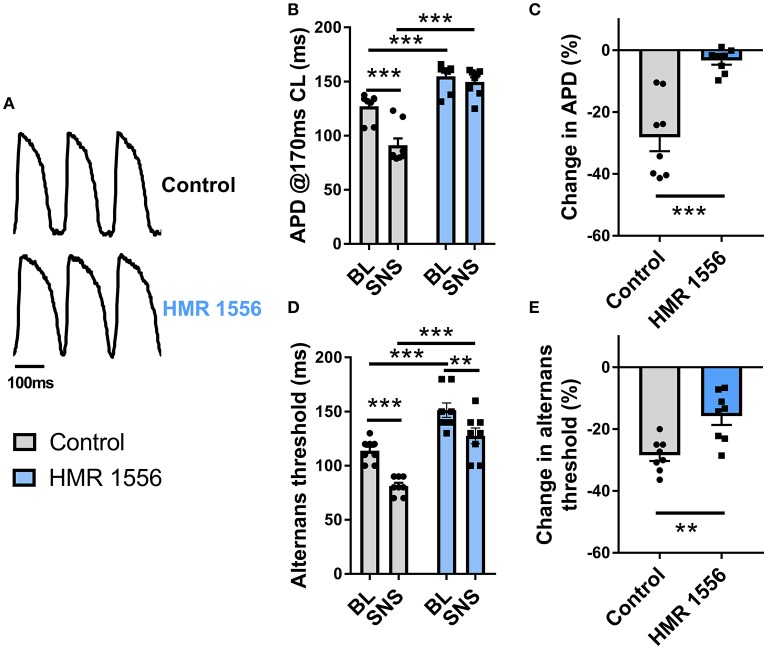
Effects of IKs block on alternans during sympathetic nerve stimulation. (A) Representative recordings of optical action potentials in control conditions and following perfusion of HMR 1556 (2 μmol/L). (B) Data showing ventricular action potential duration (APD) in control conditions and during sympathetic nerve stimulation (SNS) with and without HMR 1556. (C) Relative change in APD from baseline before and after perfusion of HMR 1556. (D) Data showing the change in the alternans threshold with SNS with and without HMR 1556. (E) Relative change in the alternans threshold before and after perfusion of HMR 1556. Data taken from a 3 × 3 pixel region in the basal left ventricle. Data represent mean ± SEM. Two-way ANOVA, with Tukey's post-hoc tests; **p < 0.01, ***p < 0.001. Paired Student's t-test; **p < 0.01, ***p < 0.001. (n = 8 hearts).